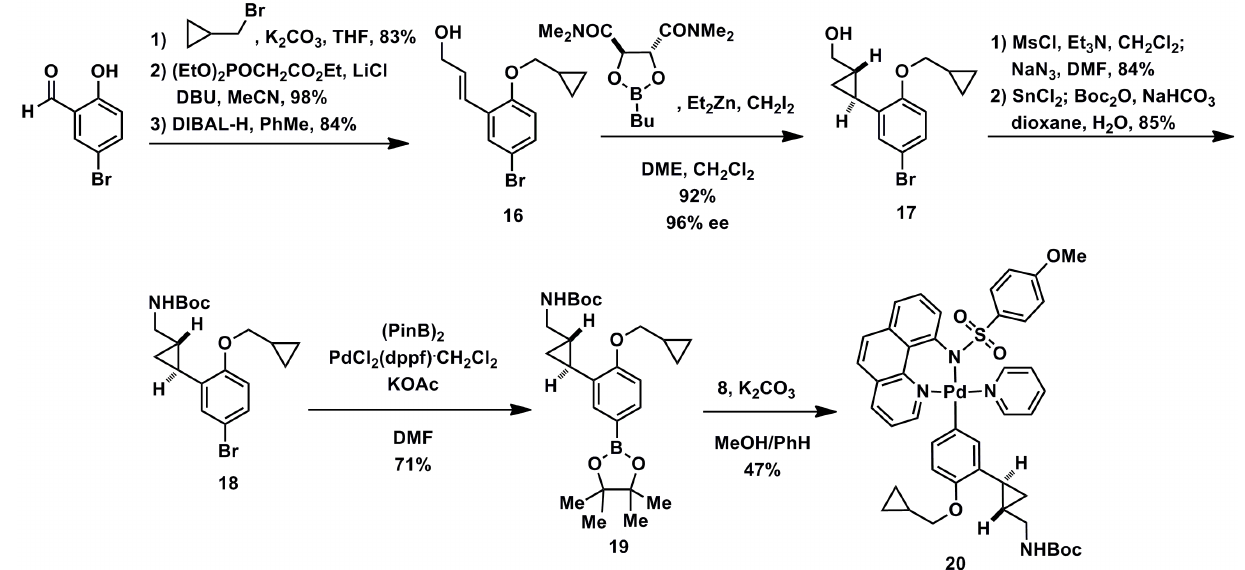
Figure 6. Synthesis of palladium(II) aryl substrate 20.